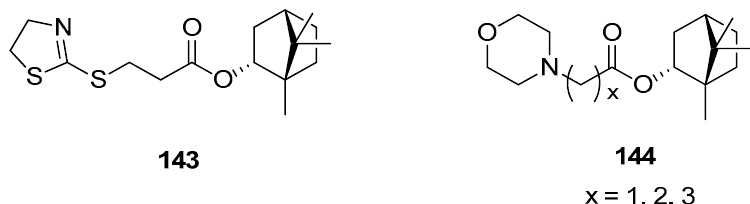
Figure 41. N -Heterocyclic esters of (–)-borneol derivatives as vaccinia virus inhibitors.